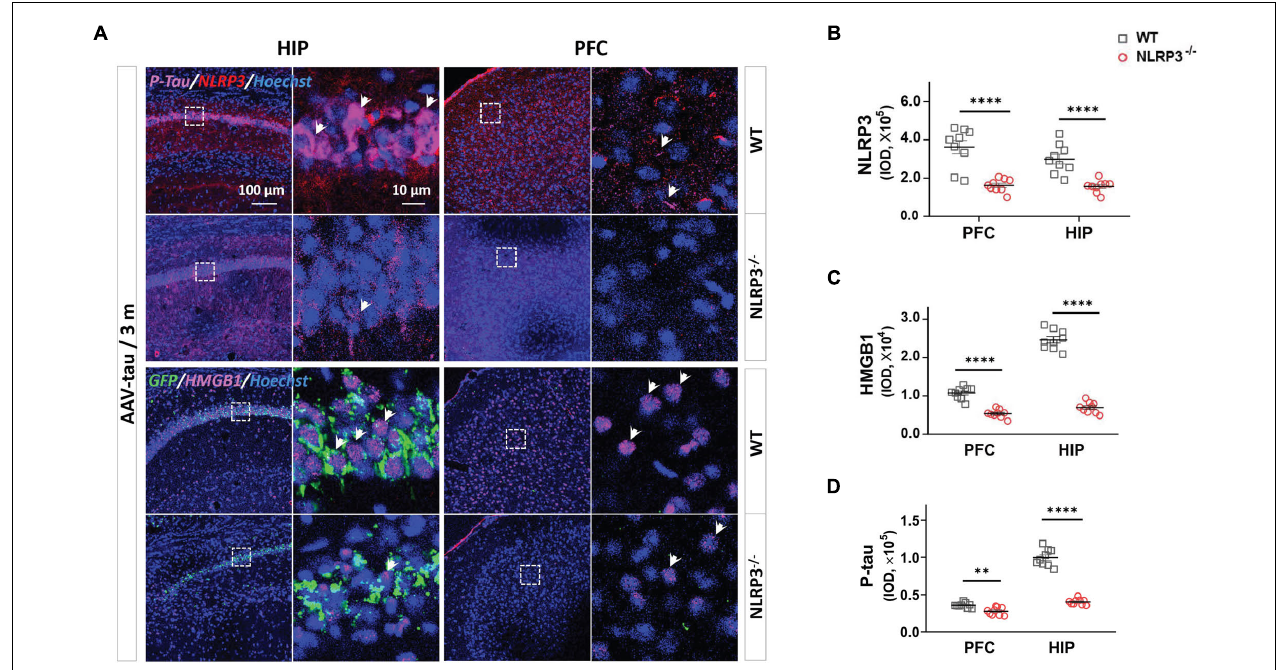
FIGURE 6 | NLRP3 - / - mice displayed the lower levels of p-tau and HMGB1 after AAV-tau injection. (A) Representative images and quantifications of (B) NLRP3, (C) HMGB1, and (D) p-tau (ser404) immunostainings in the HIP and PFC (nine ROIs from three mice for every group) of mice injected with AAV-tau or AAV-GFP 3 months after injection. White arrows indicate positive staining for p-tau or HMGB1. Unpaired t -test was performed for immunohistochemical analysis, ∗∗ p < 0.01, ∗∗∗∗ p < 0.0001. WT,